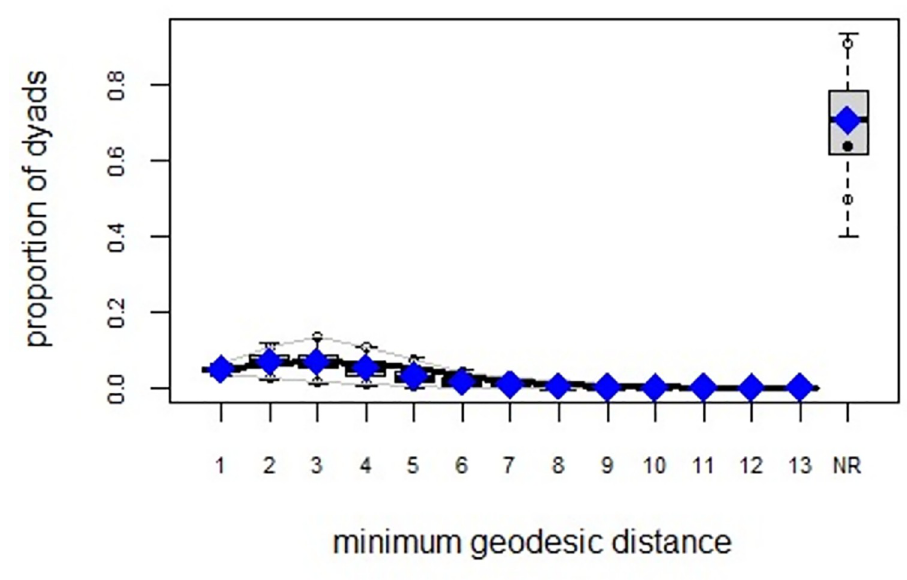
Fig 11. Multiplexity in the alpha community—goodness of fit [24] minimum geodesic distance.